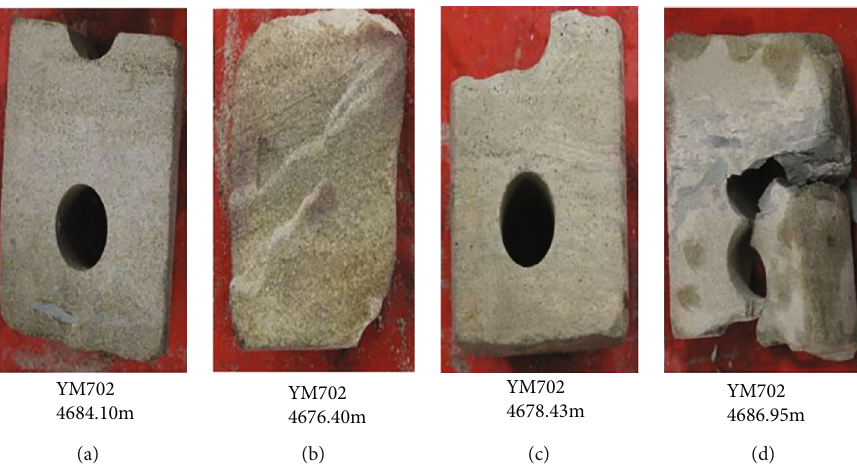
Figure 4: Core photos of Paleogene sedimentary structural types in Yingmai 7 block: (a) parallel bedding; (b) oblique bedding; (c) wavy bedding; (d) scour